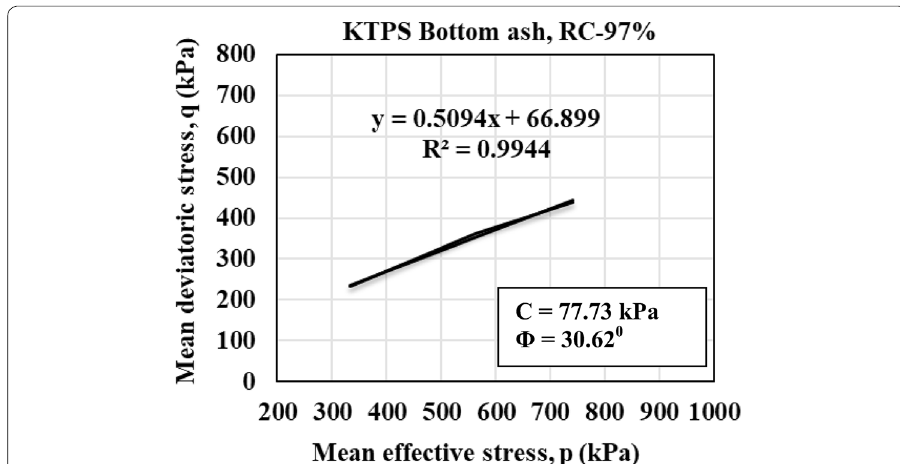
Fig. 26 p–q diagram of KTPS bottom ash at RC-97%